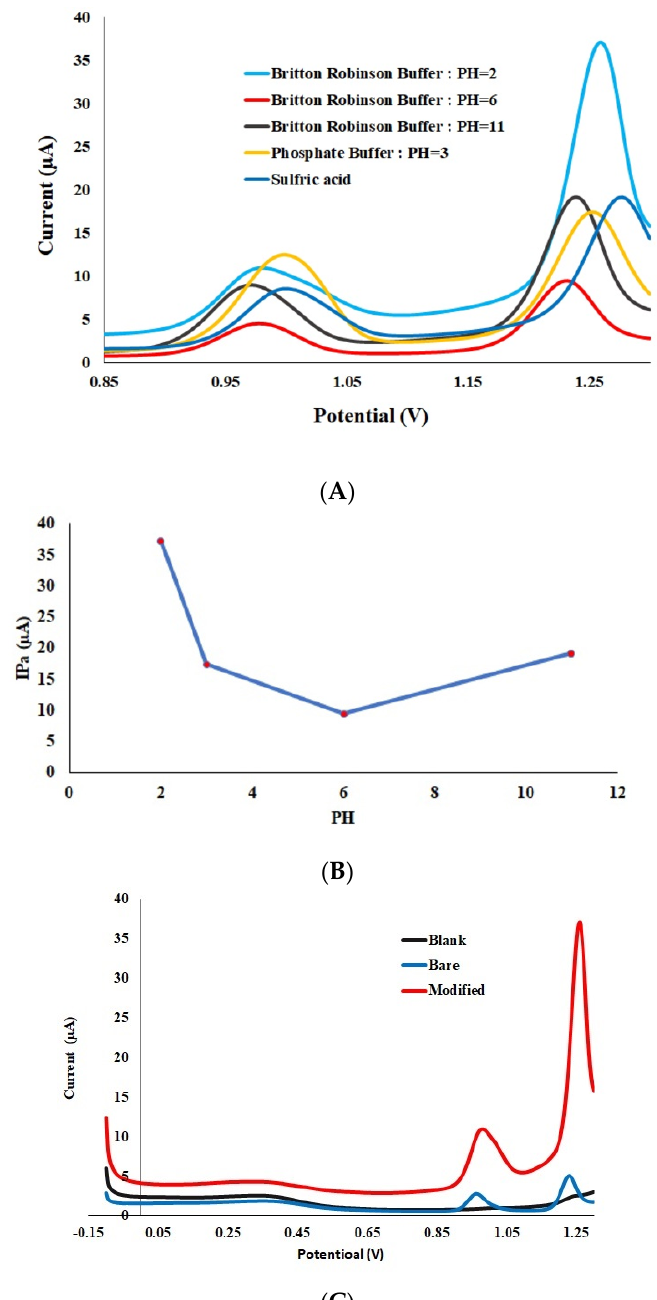
Figure 2. Voltammetric response of the modified electrode surface toward the oxidation of 1.0 × 10 − 3 M ABZ solutions. ( A ) Differential pulse voltammograms of Pt-Pd-modified GCE for ABZ solution at different buffer pH solutions. ( B ) Current variation of ABZ at modified GCE at different pH. ( C ) Differential pulse voltammograms of the bare and modified GCE in BR buffer solution containing 1.0 × 10 − 3 mol L − 1 ABZ at pH 2.